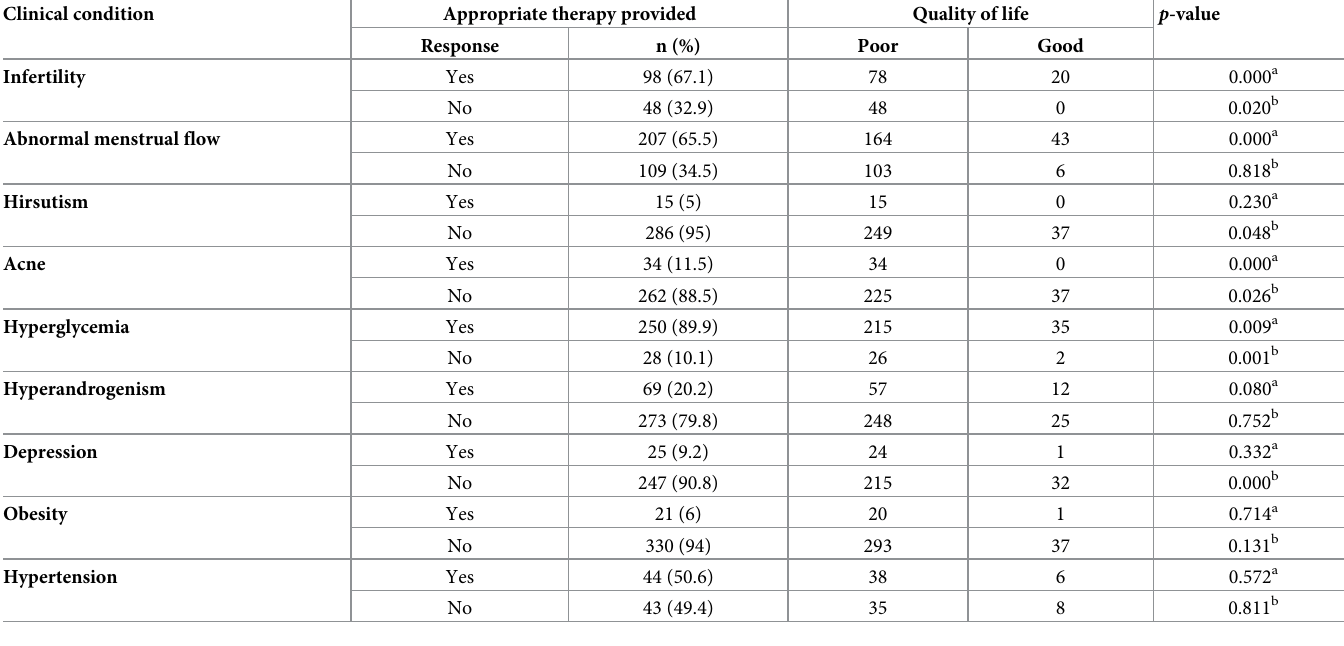
Table 6. Appropriateness of administered drug therapies for clinically significant conditions in patients with PCOS. Clinical